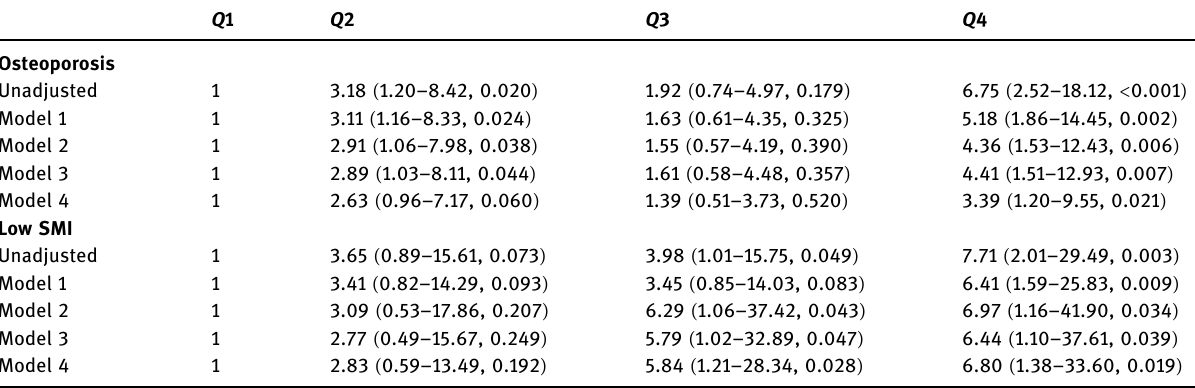
Model 1: gender, age. Model 2: gender, age, BMI. Model 3: gender, age, BMI, VitD medication. Model 4: gender, age, BMI, VitD medication, low SMI ( for osteoporosis ) ; gender, age, BMI, VitD medication, osteoporosis ( for low SMI )